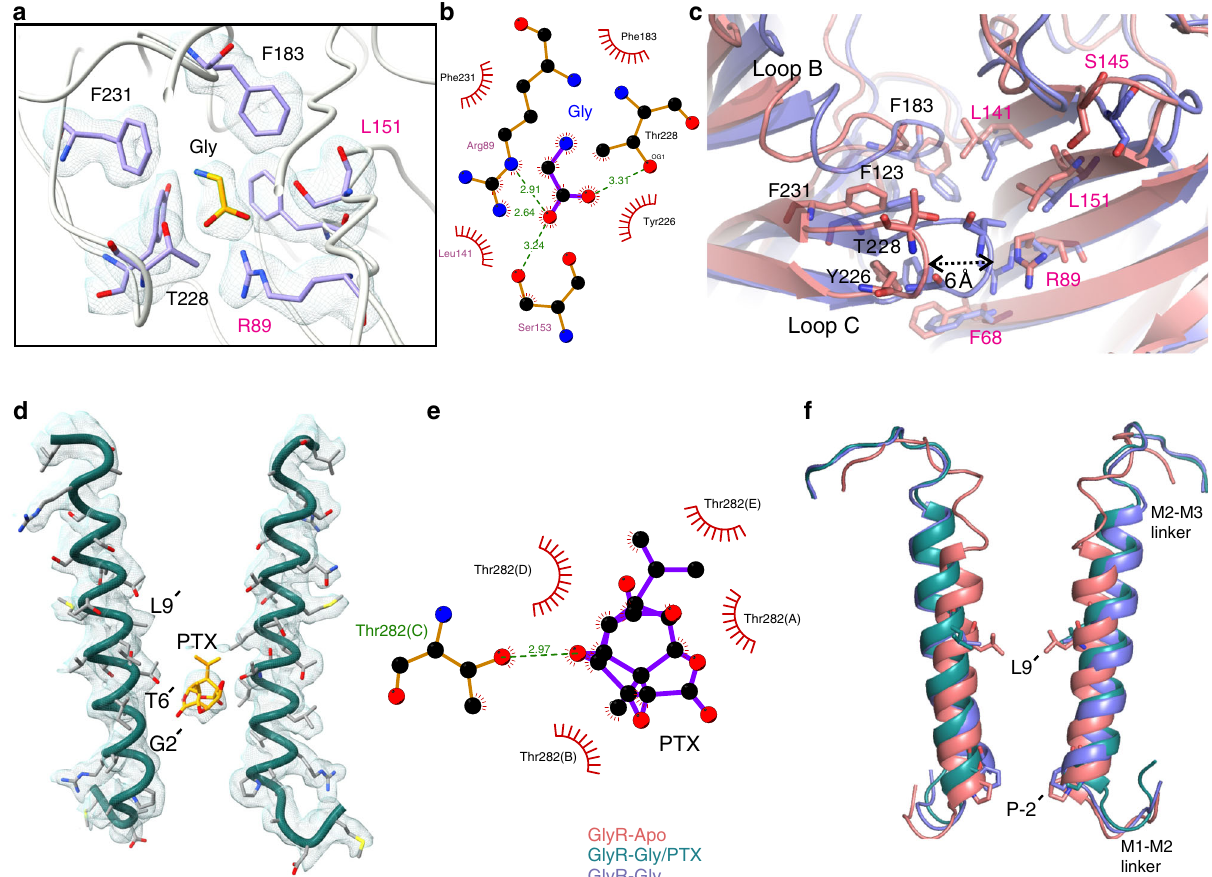
Fig. 2 Conformational changes underlying GlyR gating. a Cryo-EM density segments for neurotransmitter binding site residues and glycine ligand as seen in the GlyR – Gly structure. Residues in the principal subunit and complementary subunit are indicated in black and magenta, respectively. b LigPlot analysis of glycine orientation in the binding pocket and residues within 4 Å distance are displayed in red 70 . c Comparison of the neurotransmitter binding site for the GlyR – Apo and GlyR – Gly conformations. The residues that are involved in neurotransmitter binding are shown in sticks. d Cryo-EM map showing the density for M2 and PTX bound in the pore of GlyR – Gly/PTX. The interacting residues are shown in stick representation. For clarity, M2 for only two diagonal subunits are shown. e LigPlot analysis of PTX and the interacting residues. f A close-up of the M2 conformations is shown upon aligning the three GlyR conformations. Positions Leu9 ′ and Pro-2 ′ are shown as